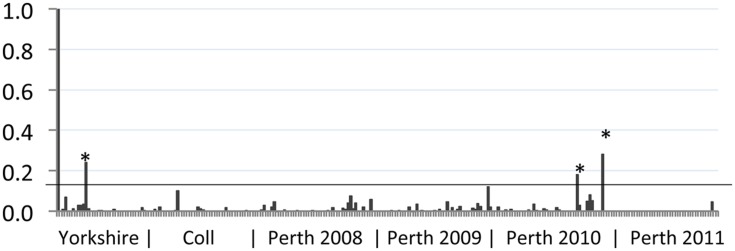
Reactivity of wild rabbit serum to bovine viral diarrhea (BVD) virus antigen. The sample to positive (S/P) value (vertical axis) for each sample tested was plotted. Control positive serum (leftmost sample 1) has an S/P value of 1 while control negative serum (sample 2) has a value of 0. The geographic source of samples is indicated beneath the chart, with year of collection for Perth samples. Samples from Yorkshire were collected between 2007 and 2014; samples from Coll were collected between 2008 and 2012. The position of the S/P value cut-off for these samples (0.13) is indicated by a horizontal line. Samples that gave S/P values >0.13 are indicated by asterisks (∗).